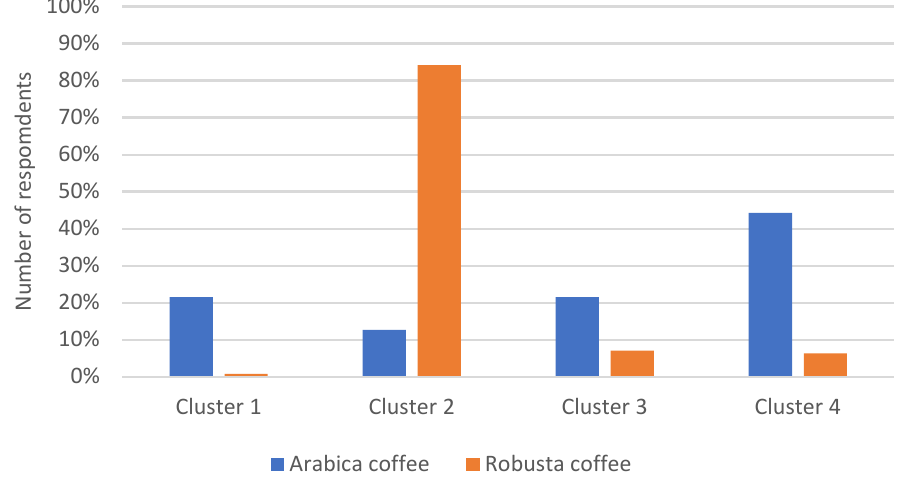
Figure 5. Number of respondents in each cluster on coffee type based.